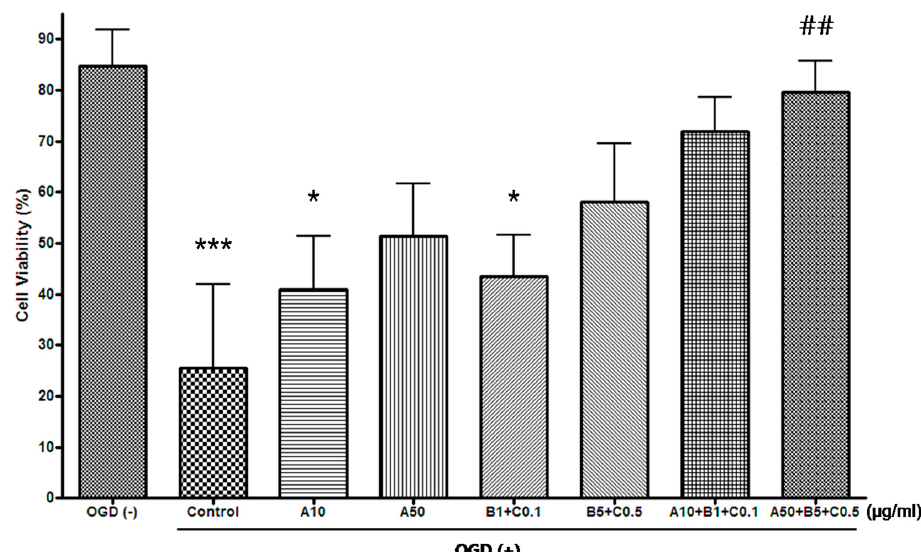
Table 4. Effects of the experimental drugs on OGD-induced cell death by cell count experiment in SH-SY5Y cells ( n = 5).